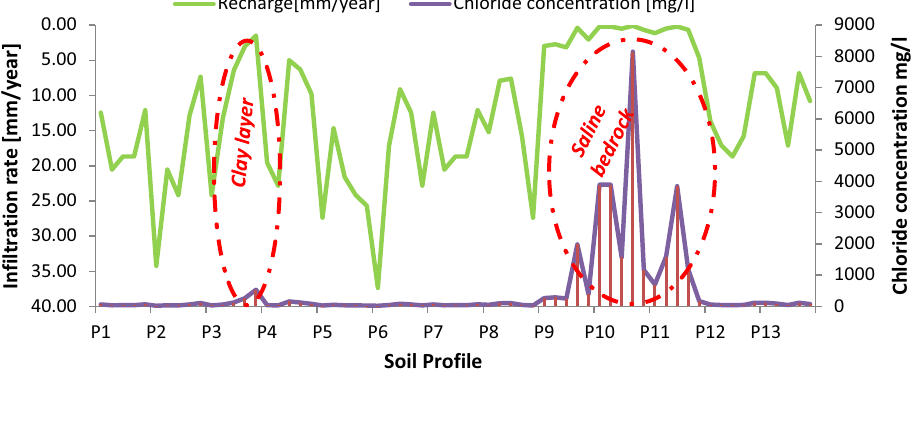
Fig. 6 Saline bedrock shown in the 2D contour plot for the profiles